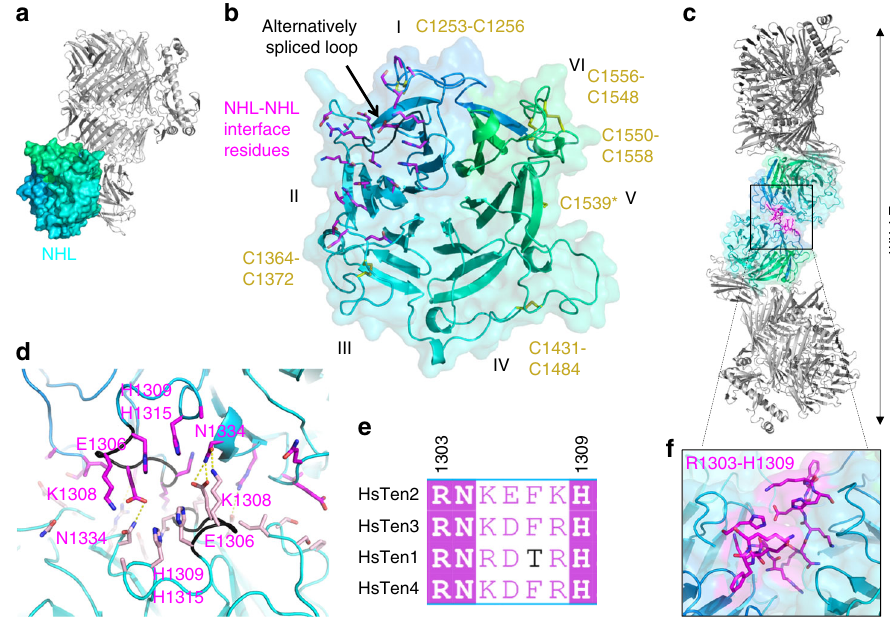
Fig. 3 The NHL domain. a The Ten2 NHL domain is shown in surface representation and coloured as in Fig. 1b. The rest of the protein is shown as grey ribbons, oriented as in Fig. 1b. b The NHL domain viewed from the outward-facing side (top face). Individual blades of the propeller are labelled with roman numerals. Residues involved in an NHL-NHL crystal contact between symmetry-related Ten2 CT monomers are shown as sticks and coloured in magenta. The backbone of an alternatively spliced loop in the Ten2 NHL domain is coloured in black. c The symmetry-related monomers of Ten2 CT are shown. The view onto the loop central to this interface (R1303-H1309) is magni fi ed in f . d Zoomed view depicting selected interfacing residues in the NHL-NHL contact. e Sequence alignment of the alternatively spliced residues located in the NHL-NHL interface. Numbers correspond to those for human Ten2. Hs Homo sapiens . f Zoomed view of the alternatively spliced residues (shown in magenta) in the NHL-NHL